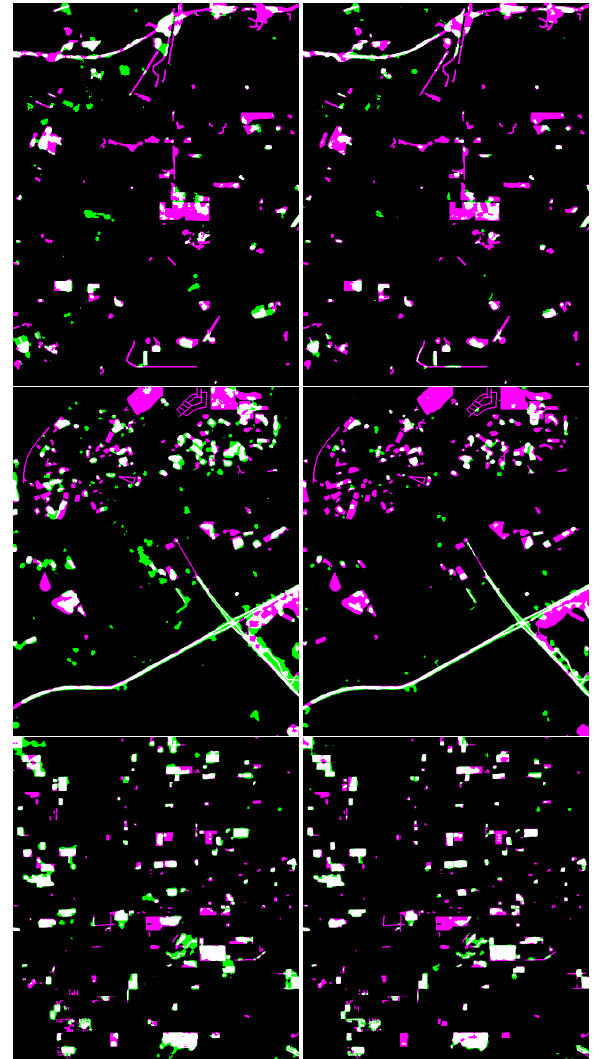
Figure 3. Exemplary change predictions. Rows: Proposed method and optical-only Siamese baseline model. Column: Three different ROI. Chonqqing, Duba and Las Vegas. Labels: White (true positive), green (false positive), violet (false negative). The results show that the proposed model is more sensitive to change, yet may also be more prone to false alarms, as compared to the